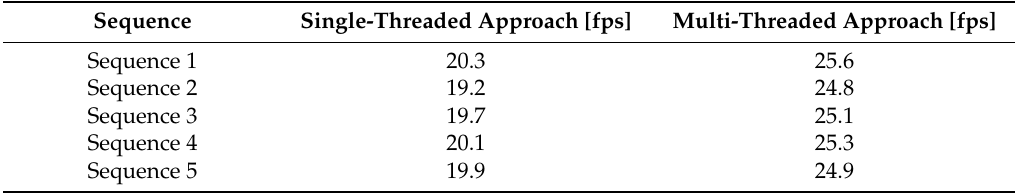
Table 5. Comparison of frame rate between single- and multi-threaded